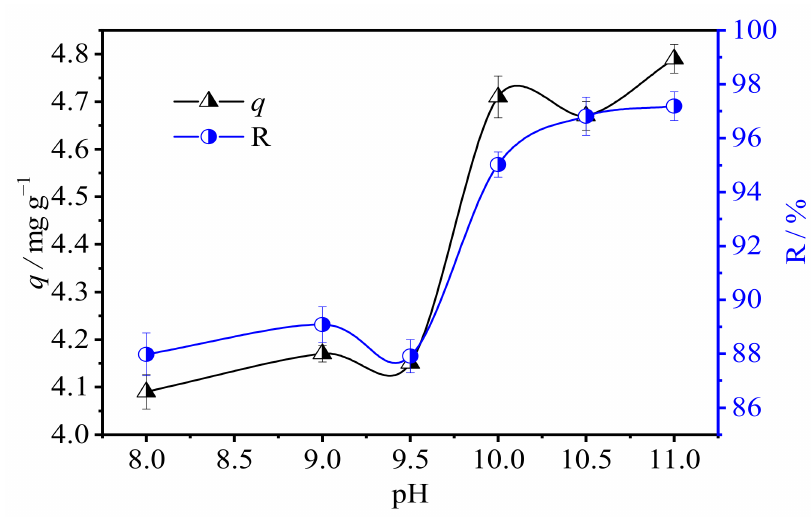
Figure 4. Effect of pH on the adsorption of U(VI) by SAIEF (C 0 = 50 mg L − 1 , solid–liquid ratio = 0.15 g L − 1 , t = 60